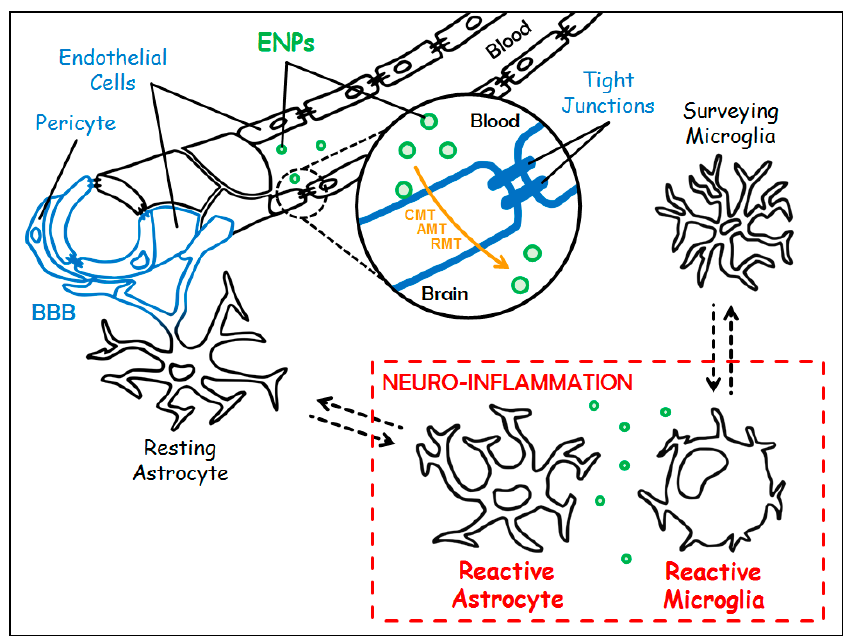
Figure 1. Targeting chronic neuro-inflammation with Engineered Nanoparticles (ENPs). The Blood-Brain Barrier (BBB) in blue is made up of a single layer of endothelial cells (sealed by tight junctions) surrounded by pericytes and astrocytic feet. Under chronic neuro-inflammation, resting astrocytes and surveying microglia switch towards reactive counterparts (in red). Customized ENPs (in green) can cross the BBB either through Carrier-Mediated Transport (CMT), Adsorptive-Mediated Transcytosis (AMT) or Receptor-Mediated Transcytosis (RMT) (in orange) to treat chronic neuro-inflammation.